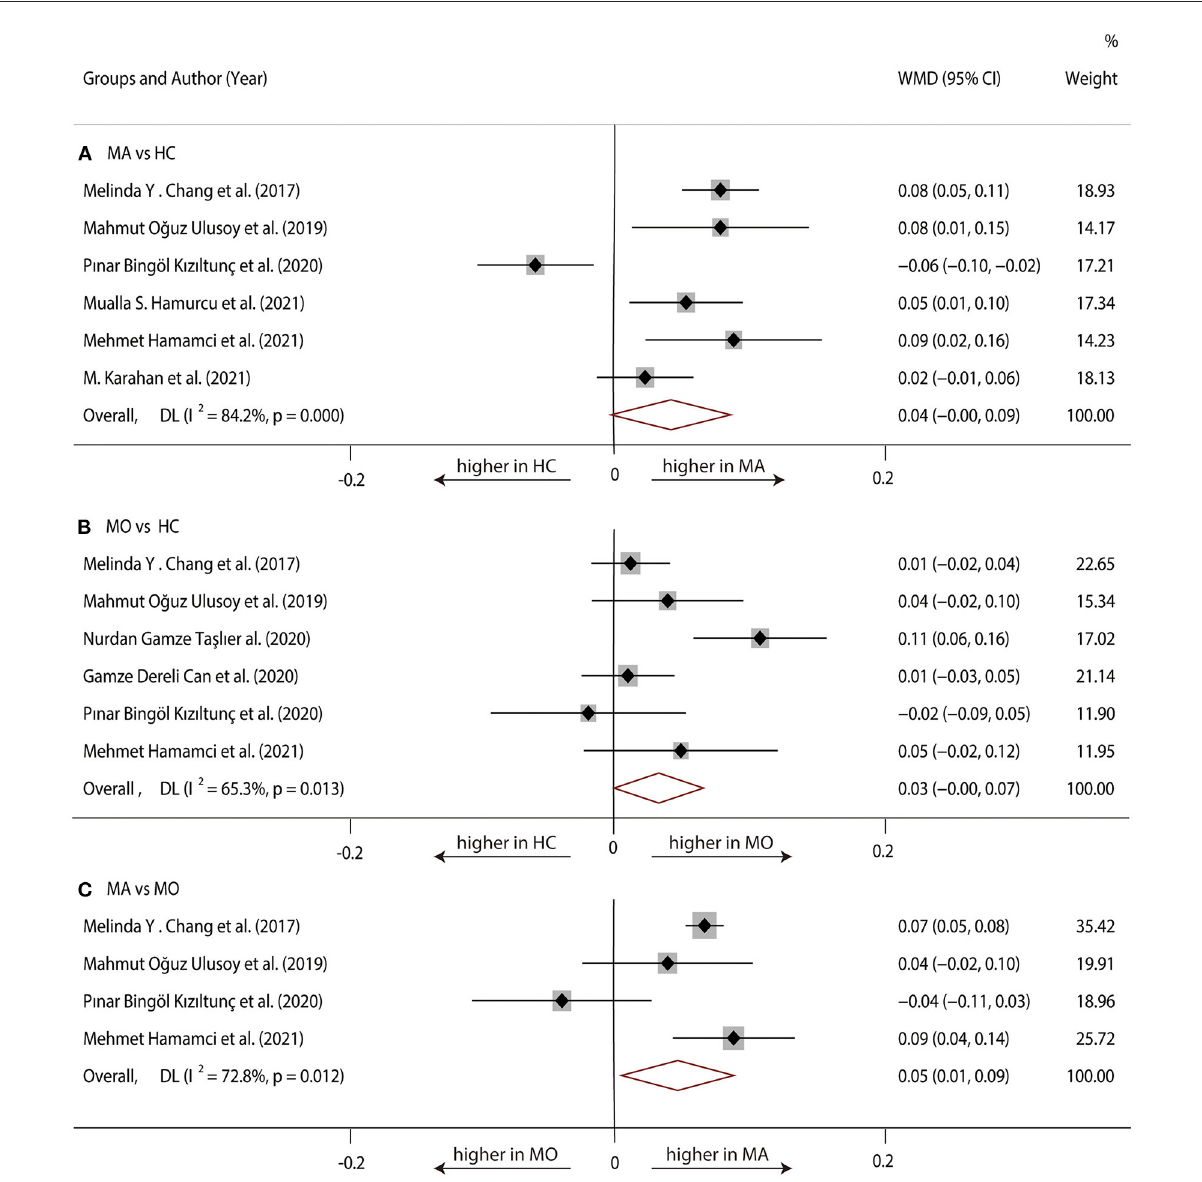
FIGURE2 Forest plot of WMD of the FAZ. (A) FAZ comparison of MA and HC; (B) FAZ comparison of MO and HC; (C) FAZ comparison of MA and